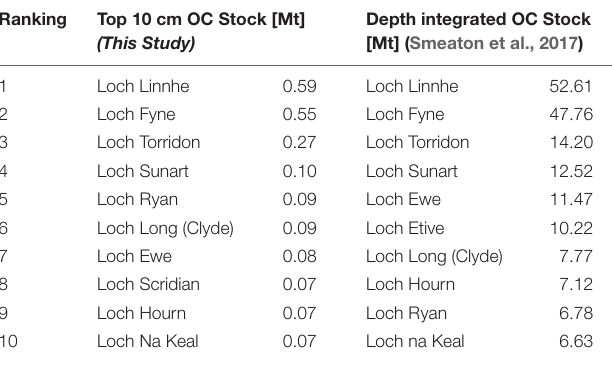
TABLE 3 | Surficial (top 10 cm) OC stocks ranked in magnitude (Mt) compared to fully depth-integrated postglacial OC stocks (Smeaton et al., 2017).